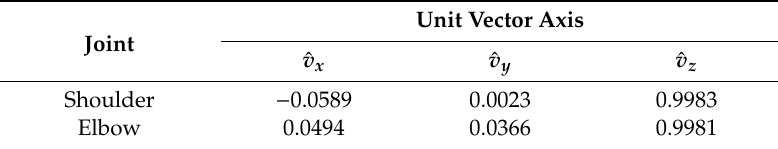
Table 4. Joints’ rotation axed with respect to the parent bodies.